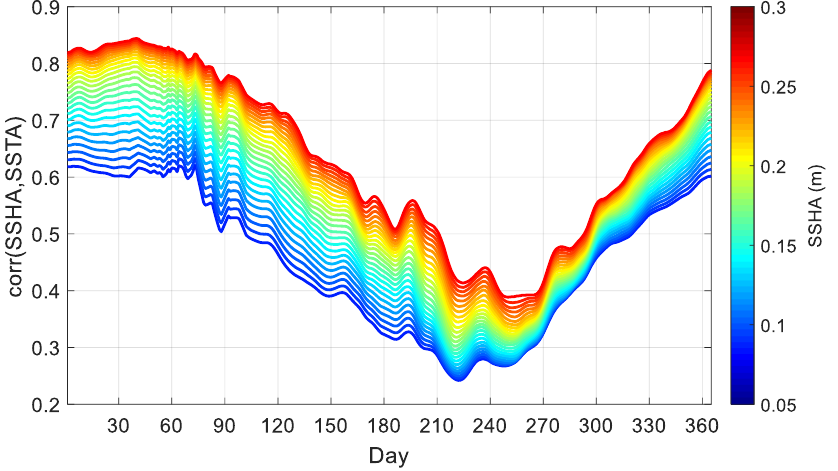
Figure 4. Daily correlations between SSHA and SSTA fields for 1993 – 2021 in the Kuroshio Extension (145° – 170°E, 25° – 45°N); the different colored lines indicate the correlation between SSHA field over a certain threshold (from 0.05 m to 0.3 m, with the interval of 0.01 m) and SSTA